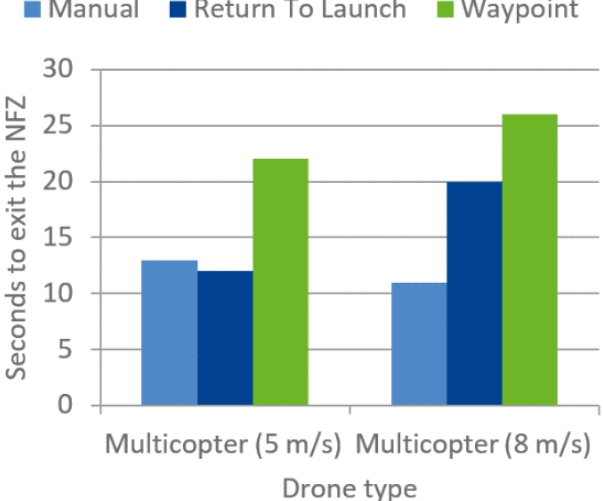
Figure 7. NFZ intrusion results. The results shown are the average of three flights each rounded